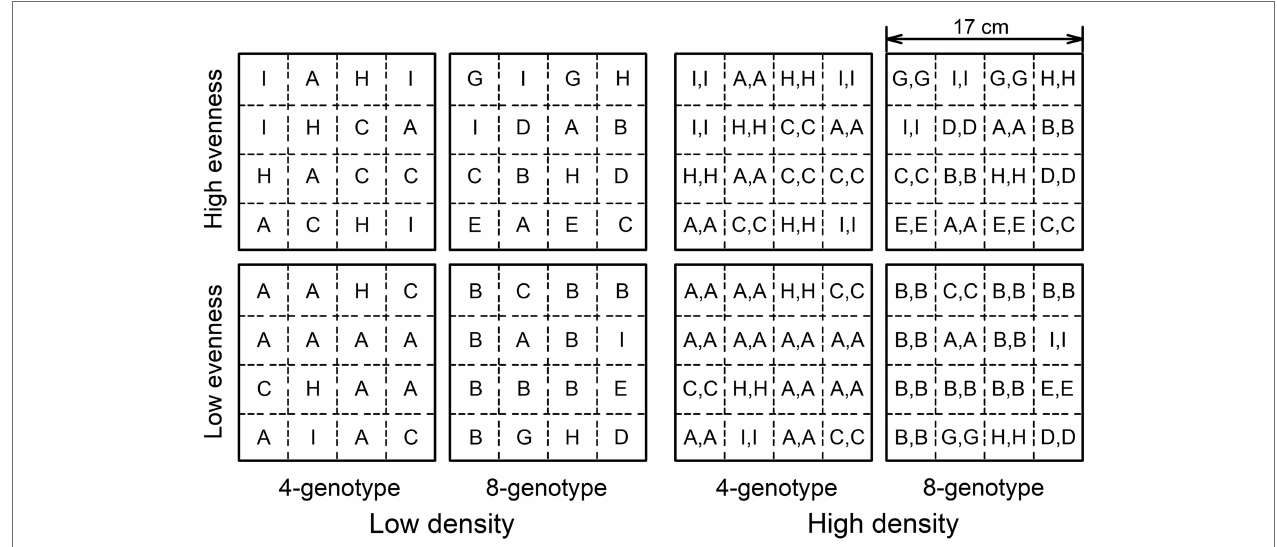
FIGURE 1 | Schematic representation of the experimental design. The experiment consisted of two levels of genotypic richness treatment (4-genotype vs. 8-genotype), two levels of genotypic evenness treatment (low evenness vs. high evenness), fully crossed with two levels of plant density treatment (low density vs. high density). 16 ramets (low density) or 32 ramets (high density) from four (low richness) or eight genotypes (high richness) were planted in a pot with the component genotypes had an equal abundance (high evenness) or not (low evenness). Different letters (A-I) represent ramets of different genotypes and mark the initial planting positions (presented are the genotype composition and planting patterns in one of the ten randomly selected